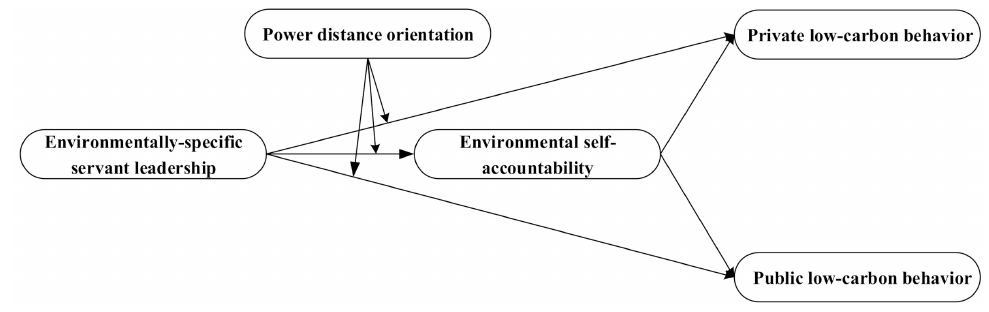
Figure 1. Conceptual